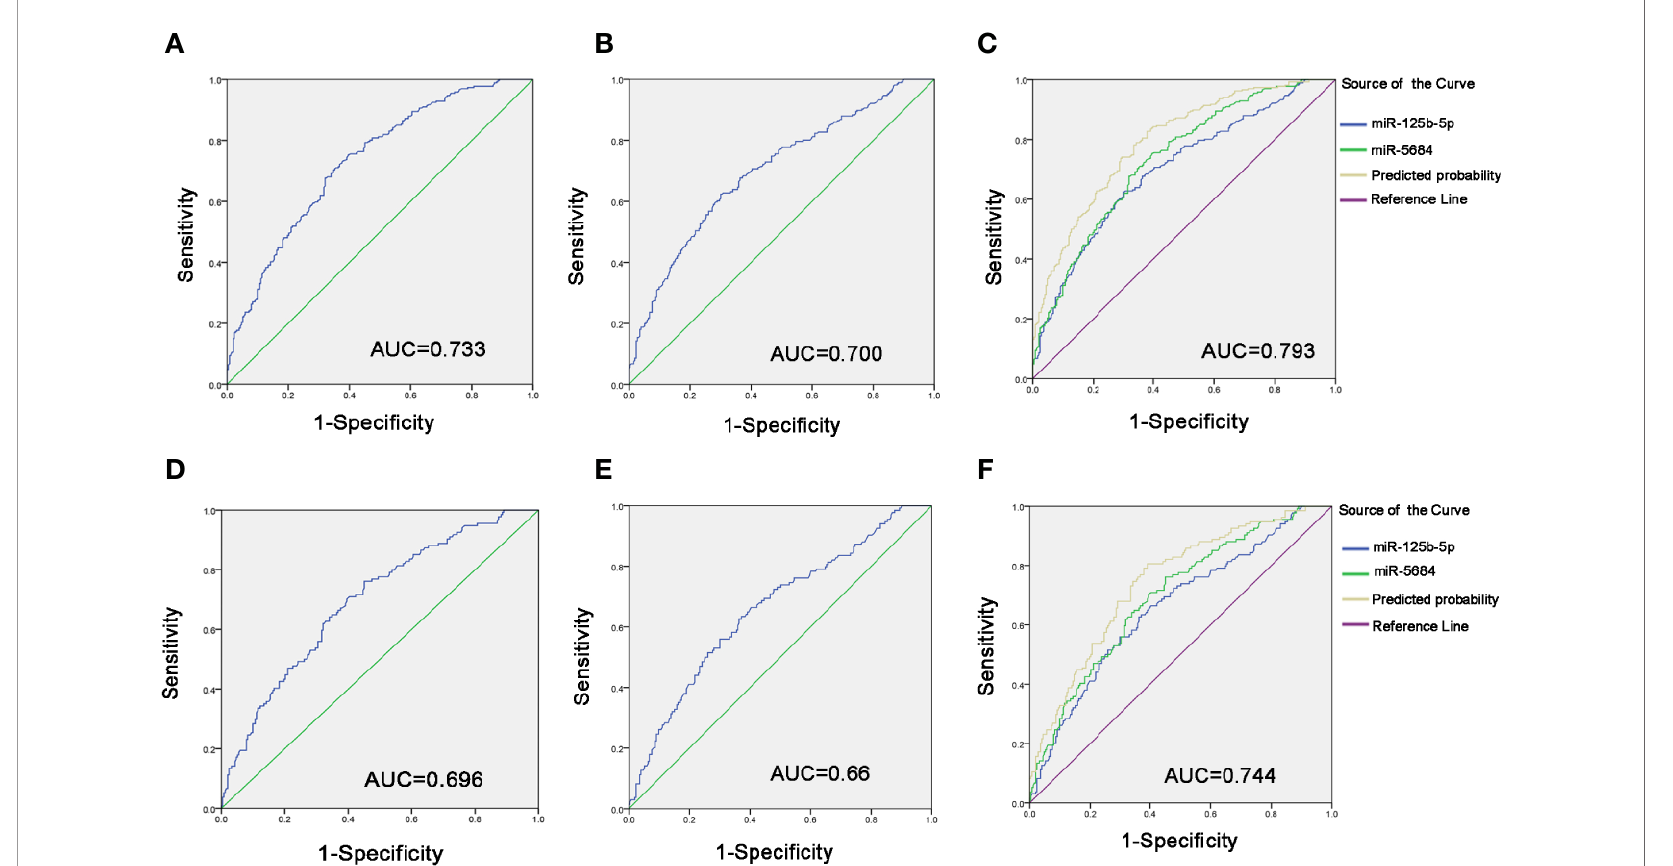
FIGURE 5 | Diagnostic role of serum exosomal miRNA expression levels in NSCLC patients. The AUCs of miR-5684 (A) , miR-125b-5p (B) , and both (C) in NSCLC patients relative to healthy donors. The AUCs of miR-5684 (D) , miR-125b-5p (E) , and both (F) in early-stage NSCLC patients relative to healthy